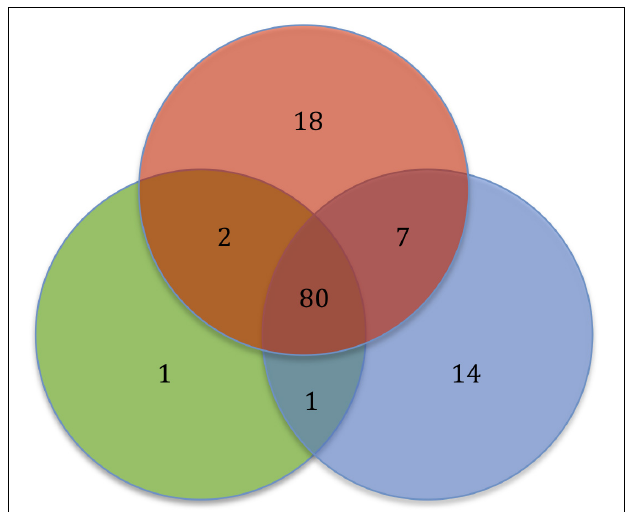
FIGURE 7 | Diagram showing the Serratia spp. resistome based on the bacterial niche. Pathogens (red), environmental (blue), and symbiotic (green).